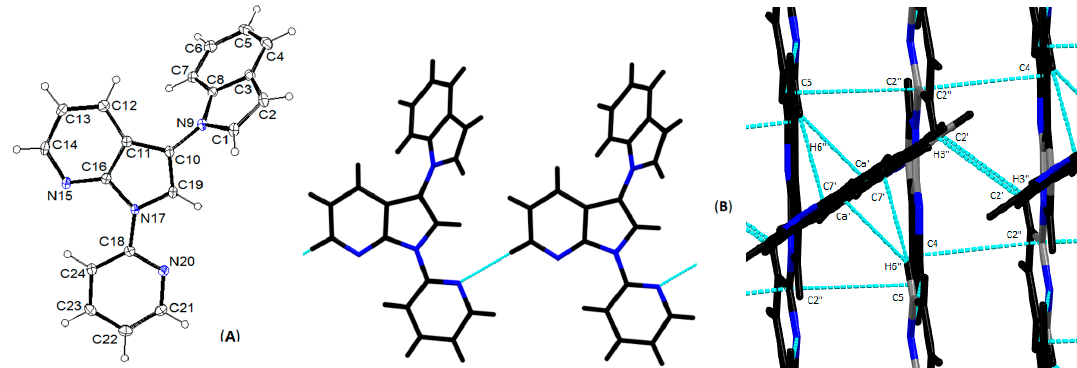
Figure 13. ORTEP diagrams (30% probability) of 5i ( A ); short-contact networks observed for 5i ( B ).